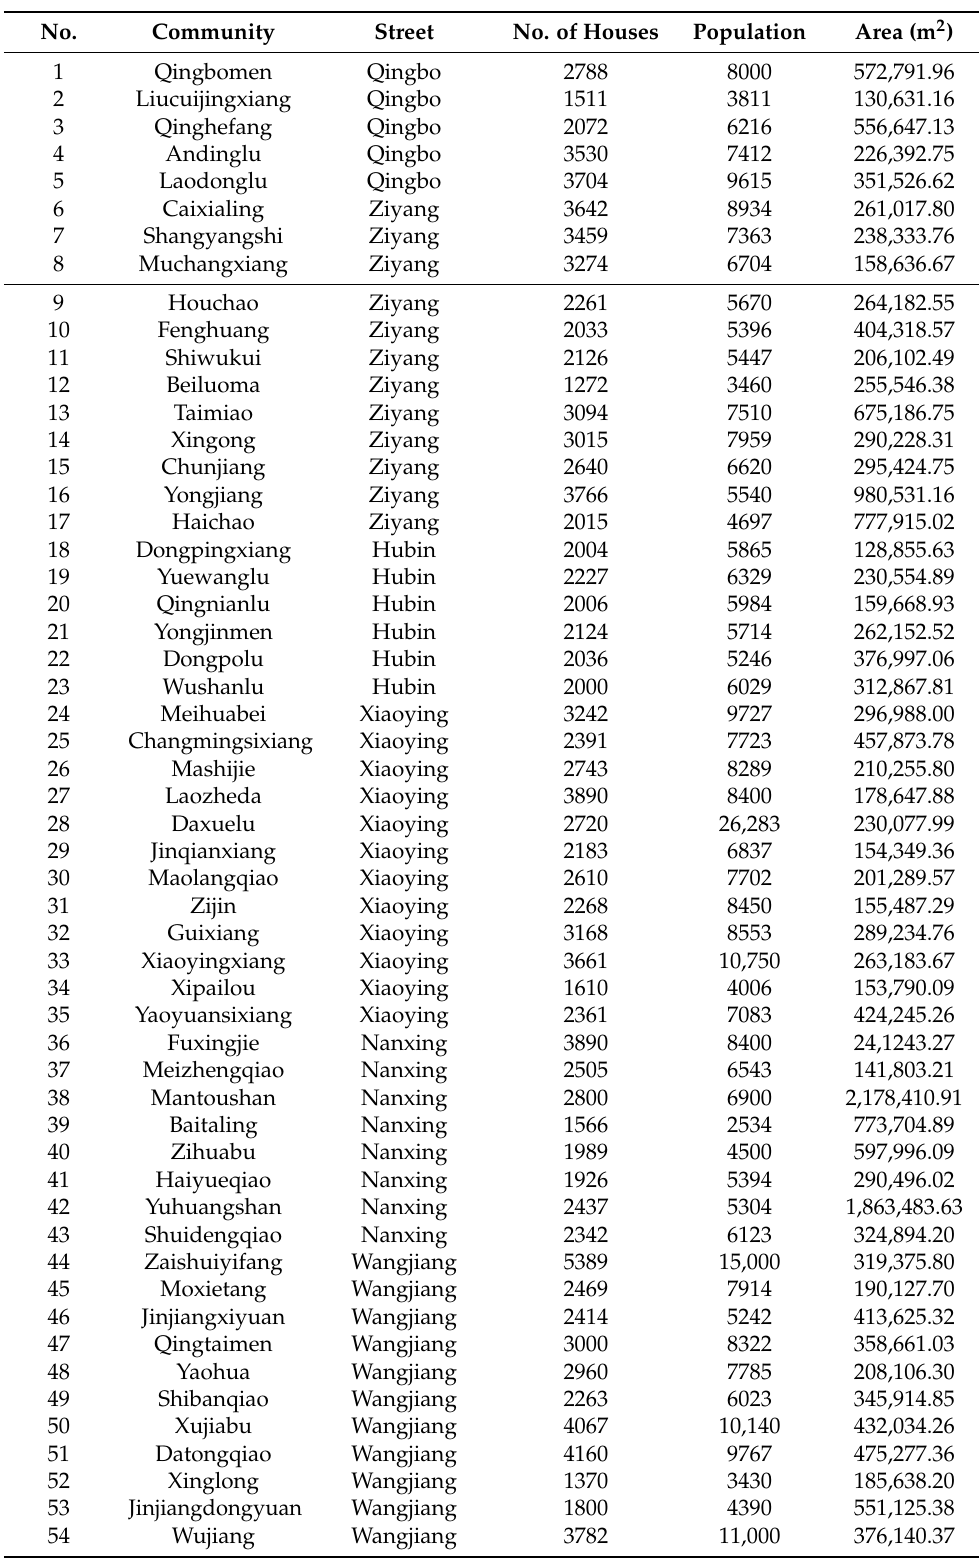
Table 14. Information of different